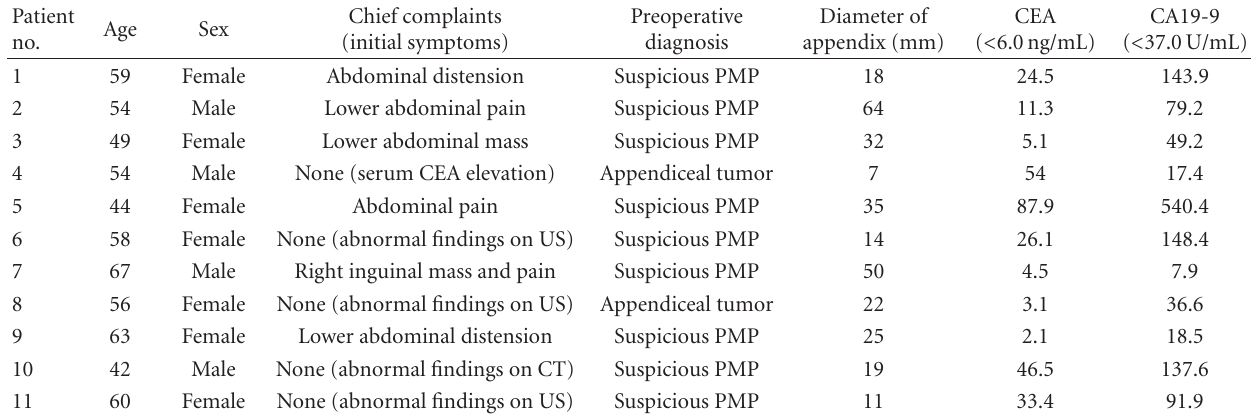
Table 1: Profiles of patients.